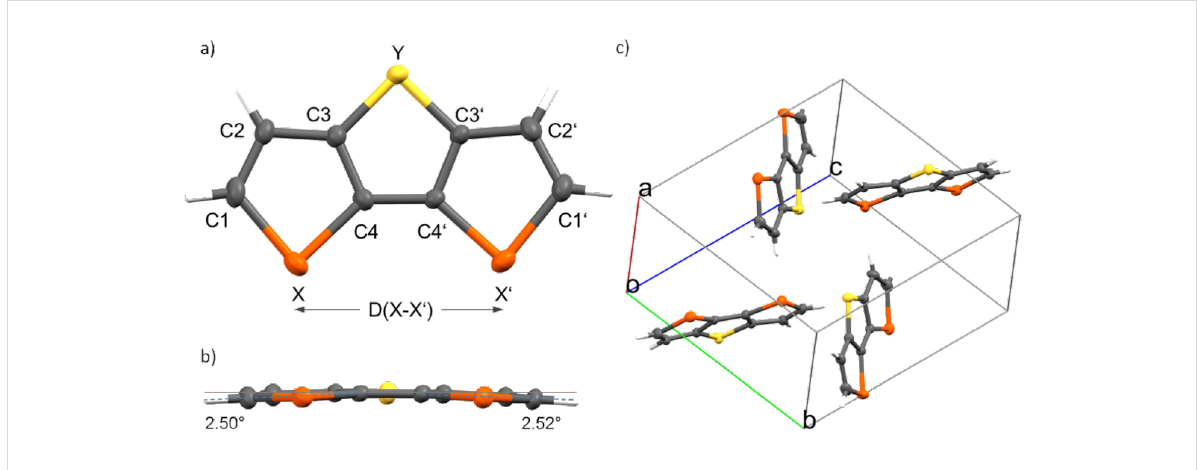
Figure 2: Single crystal X-ray structure analysis of selenolotriacene DST 3 , (a) individual molecule and atom numbering (top view); (b) side view. (c) Herringbone-type packing structure of the four molecules in the unit.